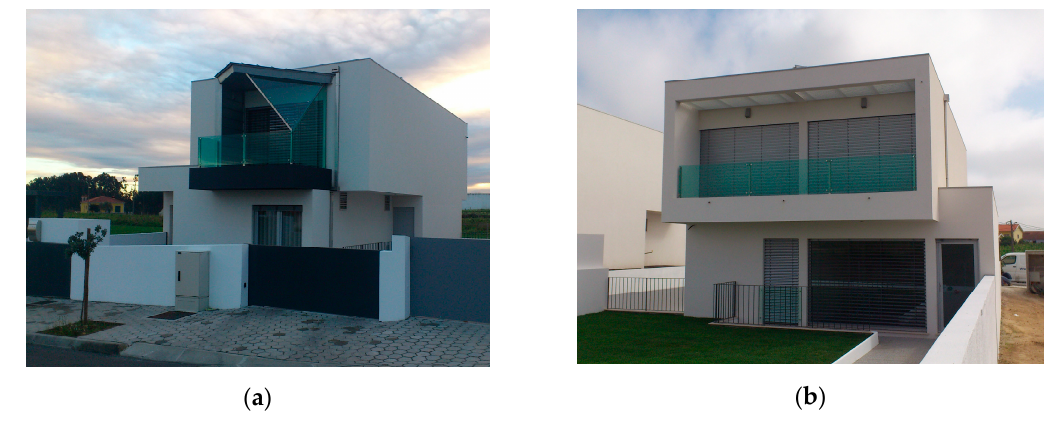
Figure 3. Case study: ( a ) northeast external wall; ( b ) southwest external wall.